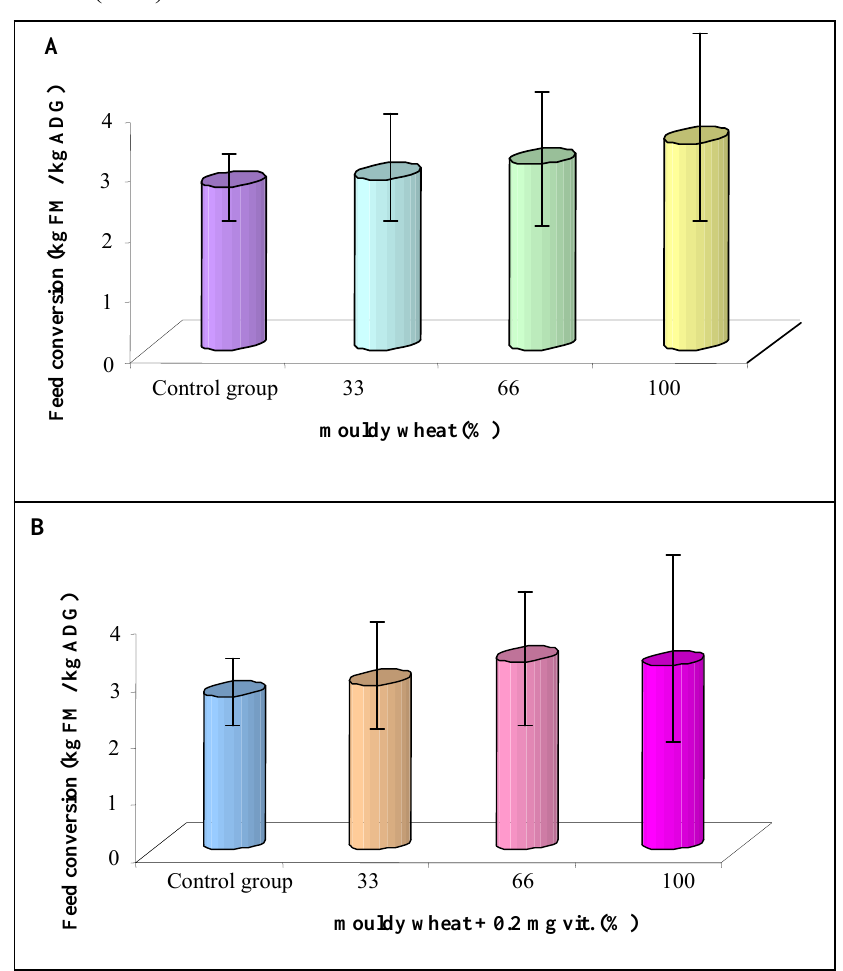
Figure 5. (A) Feed conversion of rats administered by various doses of mouldy wheat (Table 1) and vitamins according to NRC at the end of the experiment (4 weeks). We found out that the control group had the best feed conversion (2.70). The worst feed conversion had the group fed with 100% mouldy wheat (3.43). (B) Feed conversion of groups administered by various doses of mouldy wheat (Table 1) and 100% higher dose of vitamins than suggested by NRC at the end of the experiment (4 weeks). The control group had the best feed conversion (2.71). The worst feed conversion had the group with 66% mouldy wheat